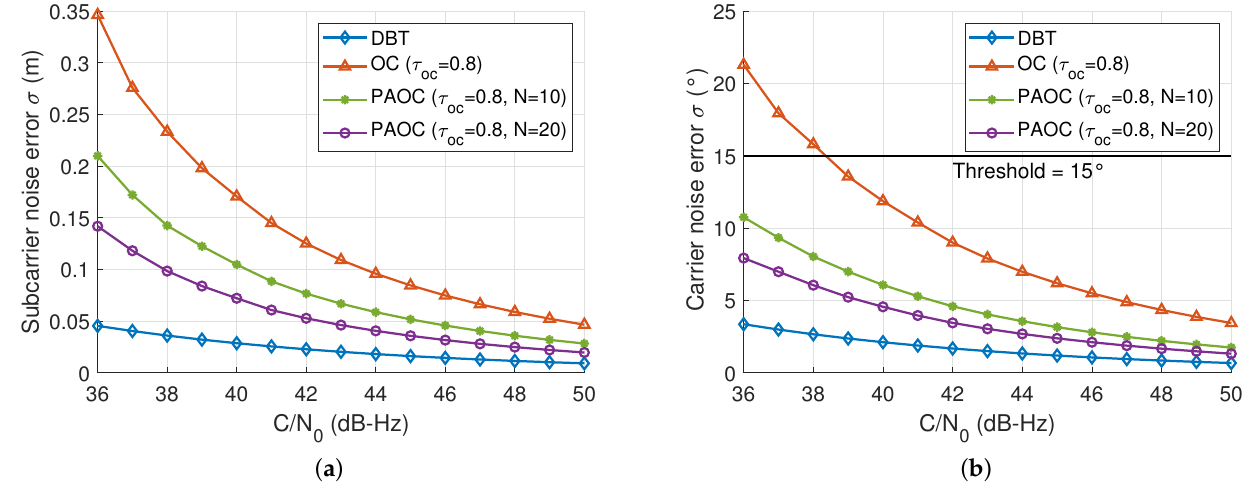
Figure 8. Tracking jitters of the DBT, OC, and PAOC techniques for the BOC (15, 2.5) signal with a bandwidth of 40.96 MHz: ( a ) subcarrier noise error; ( b ) carrier noise